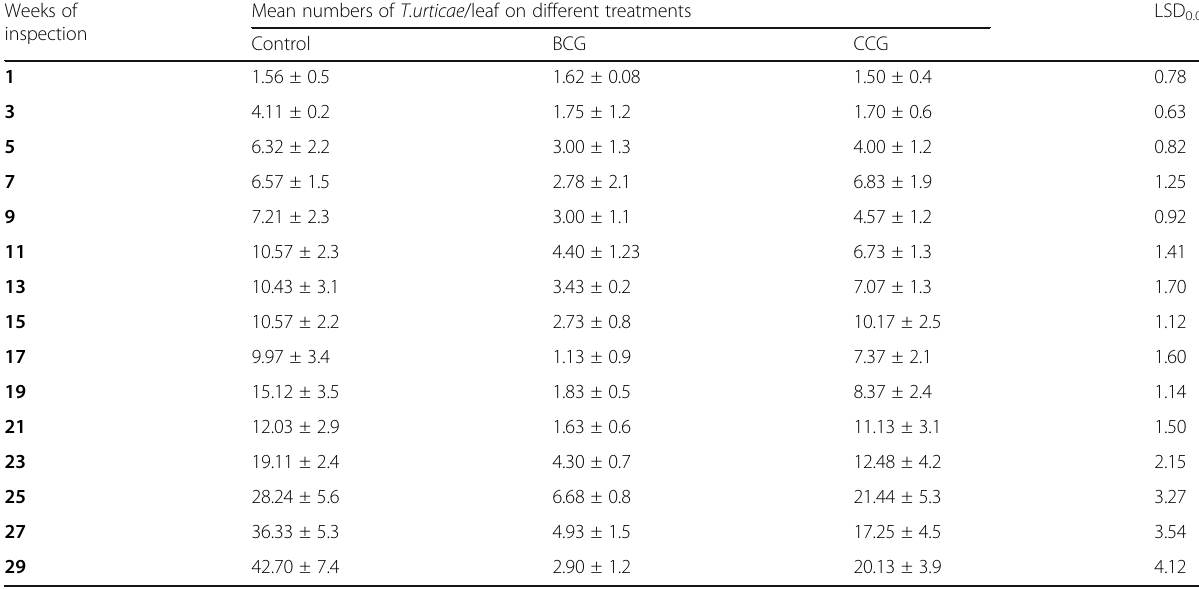
Table 4 Mean counts of T.urticae /leaf on the sweet pepper in the greenhouse during the winter plantation of 2016/17 Weeks of Mean numbers of T.urticae /leaf on different treatments inspection